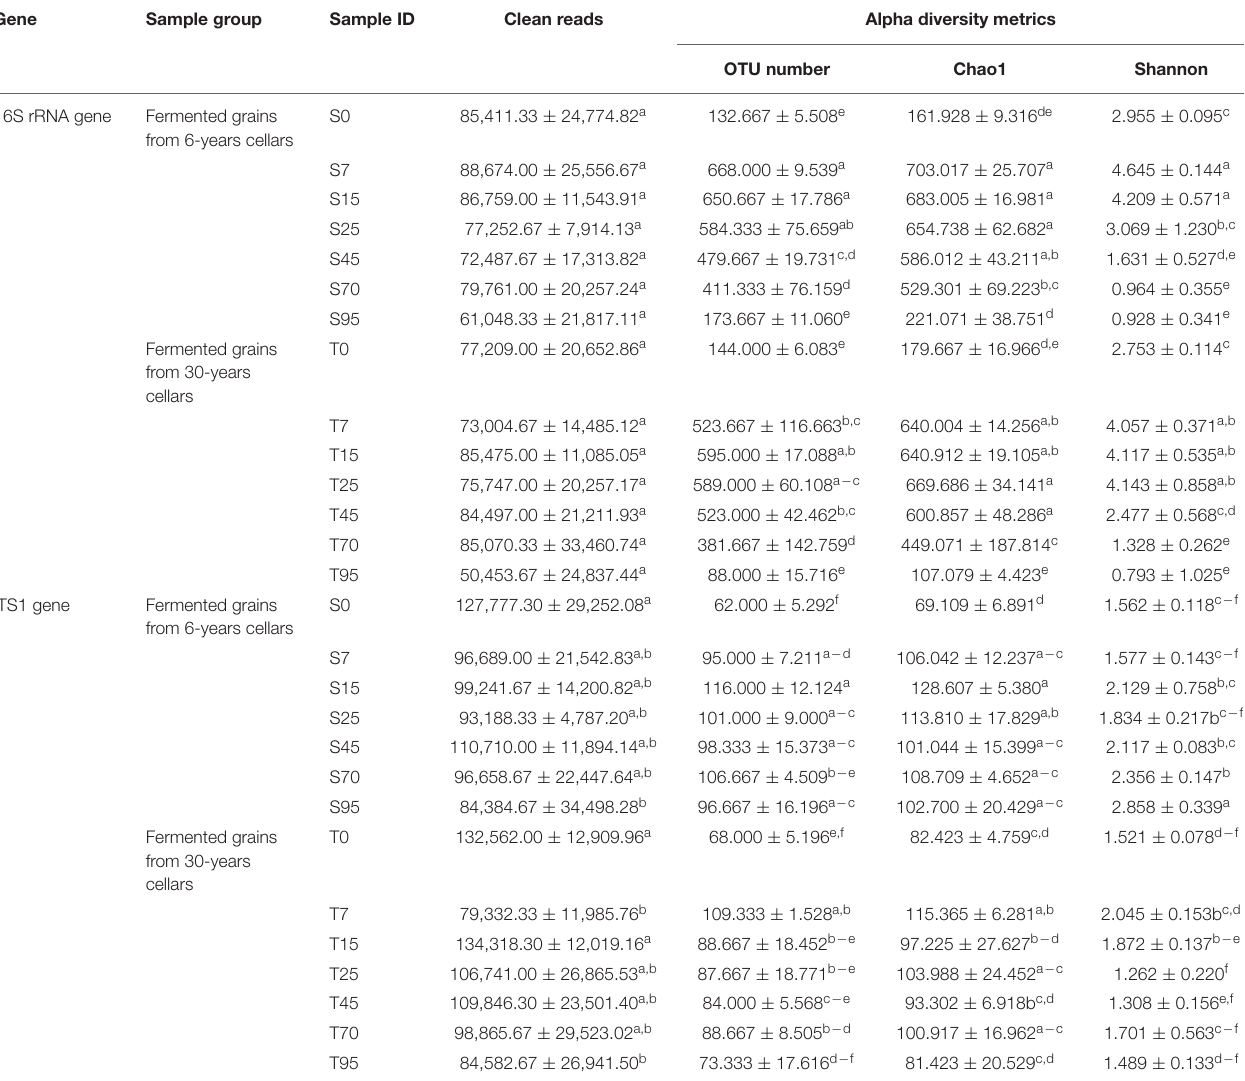
TABLE 2 | Summary of diversity index for microbial communities based on 16S rRNA and ITS1 gene sequencing data (cutoff = 0.005).